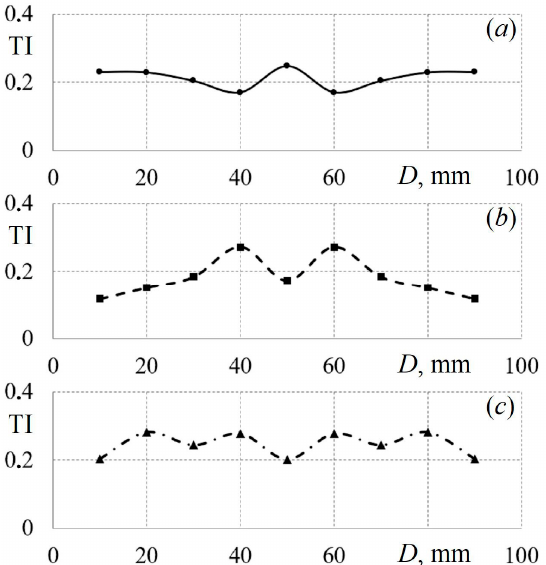
Figure 8. Change in turbulence intensity TI (in the first section H 1 = 100 mm) along the cylinder diameter D when air is supplied to the diffuser through tubes of various configurations: ( a )—round tube ( w 1 ≈ 6.65 m/s, TI 1 = 0.213); ( b )—square tube ( w 1 ≈ 6.45 m/s, TI 1 = 0.180); ( c )—triangular tube ( w 1 ≈ 6.65 m/s, TI 1 = 0.245).